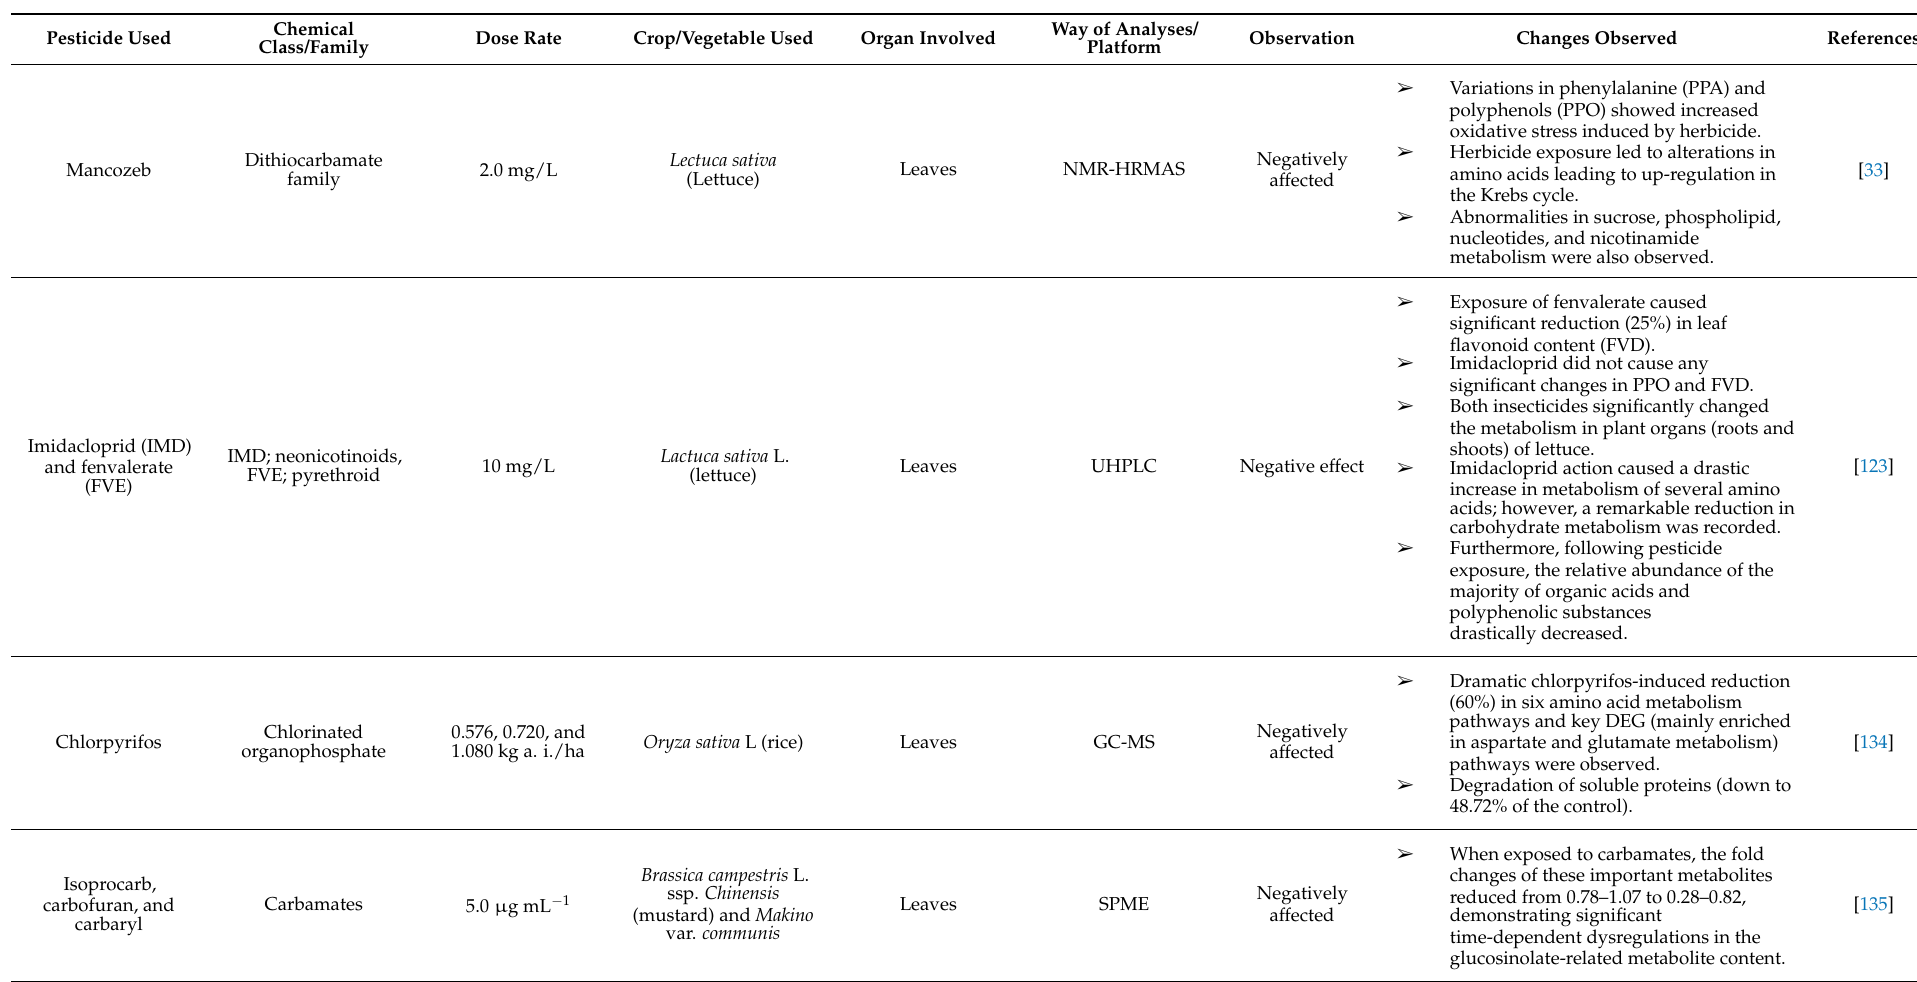
Table 2. Metabolomics approaches involved in the assessment of pesticide–plant